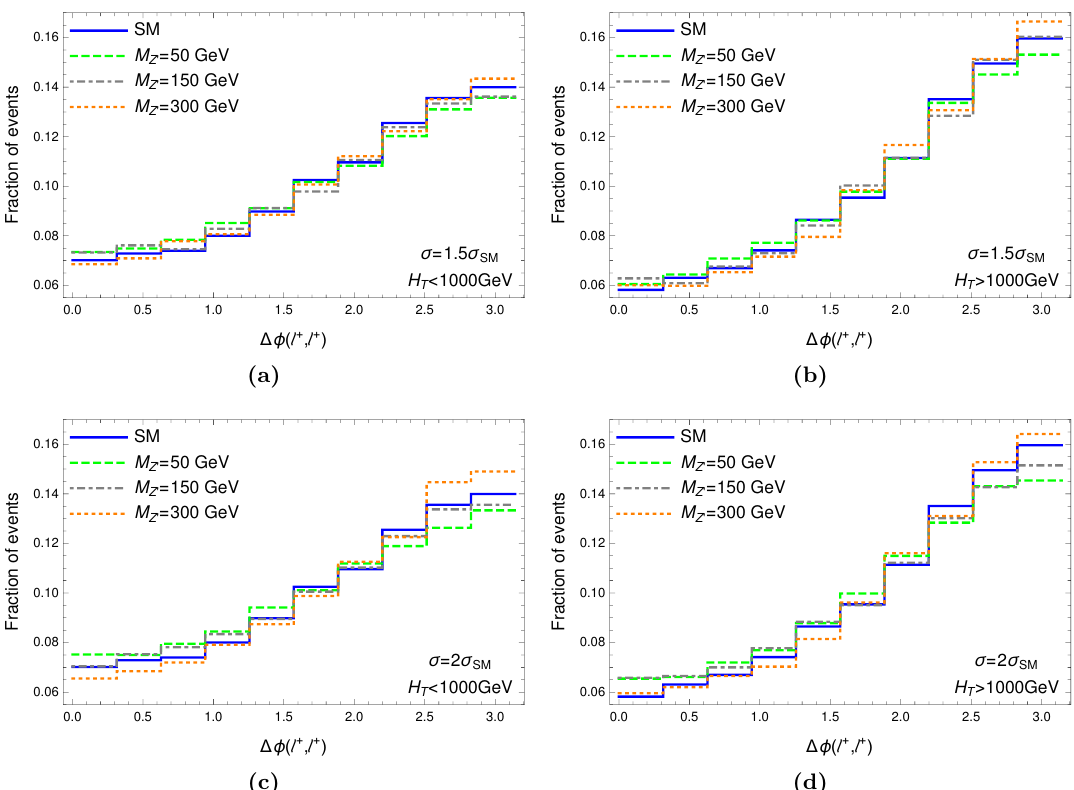
Figure 13. Distribution of the azimuthal separation between the same-sign leptons, (cid:1) (cid:30) ( ‘ + ; ‘ + ), for the 2LSS channel after preselection (see text for details) with (left) H T < 1000 GeV and (right) H T > 1000 GeV, normalized to unit area. Shown are the predictions for the SM (blue) and the Z 0 model for (a, b) the tight benchmark points (i.e. giving (cid:27) = 1 : 5 (cid:27) SM ) and (c, d) the loose benchmark points (i.e. giving (cid:27) = 2 (cid:27) SM ).